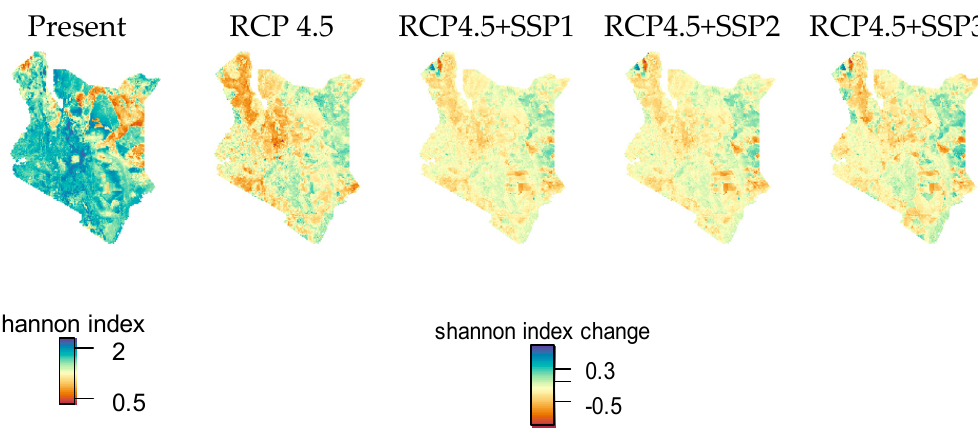
Figure 7. Shannon’s diversity index at present and changes in 2050, under RCP 4.5 and SSP scenarios.